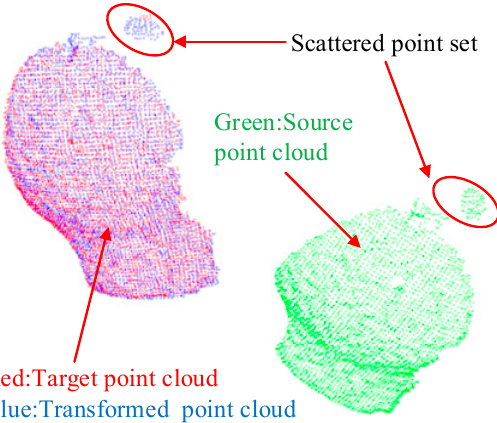
Figure 14. Typical phenomenon of the scattered point cloud. These scattered points are not removed by the statistical outlier removal method in the preprocessing phase, mainly because the points in the scattered point set are very dense and cannot be removed at one time by the algorithm.